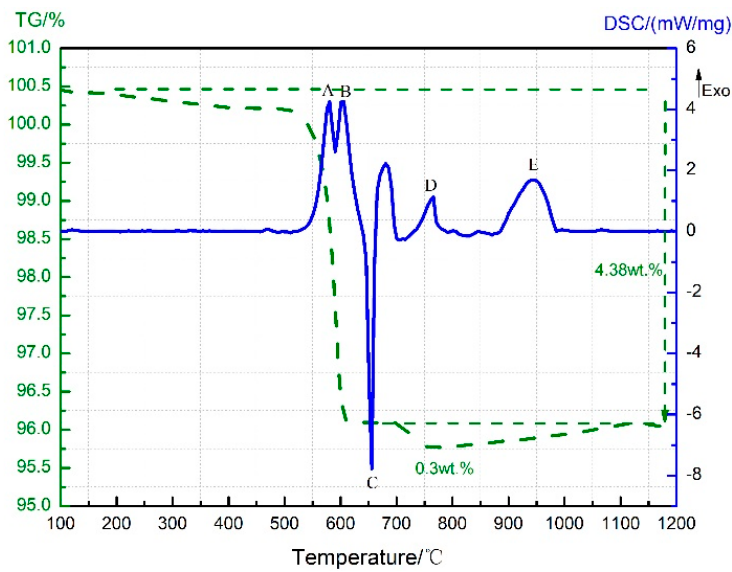
Figure 5. TG-DSC curve of Al/MnO 2 .